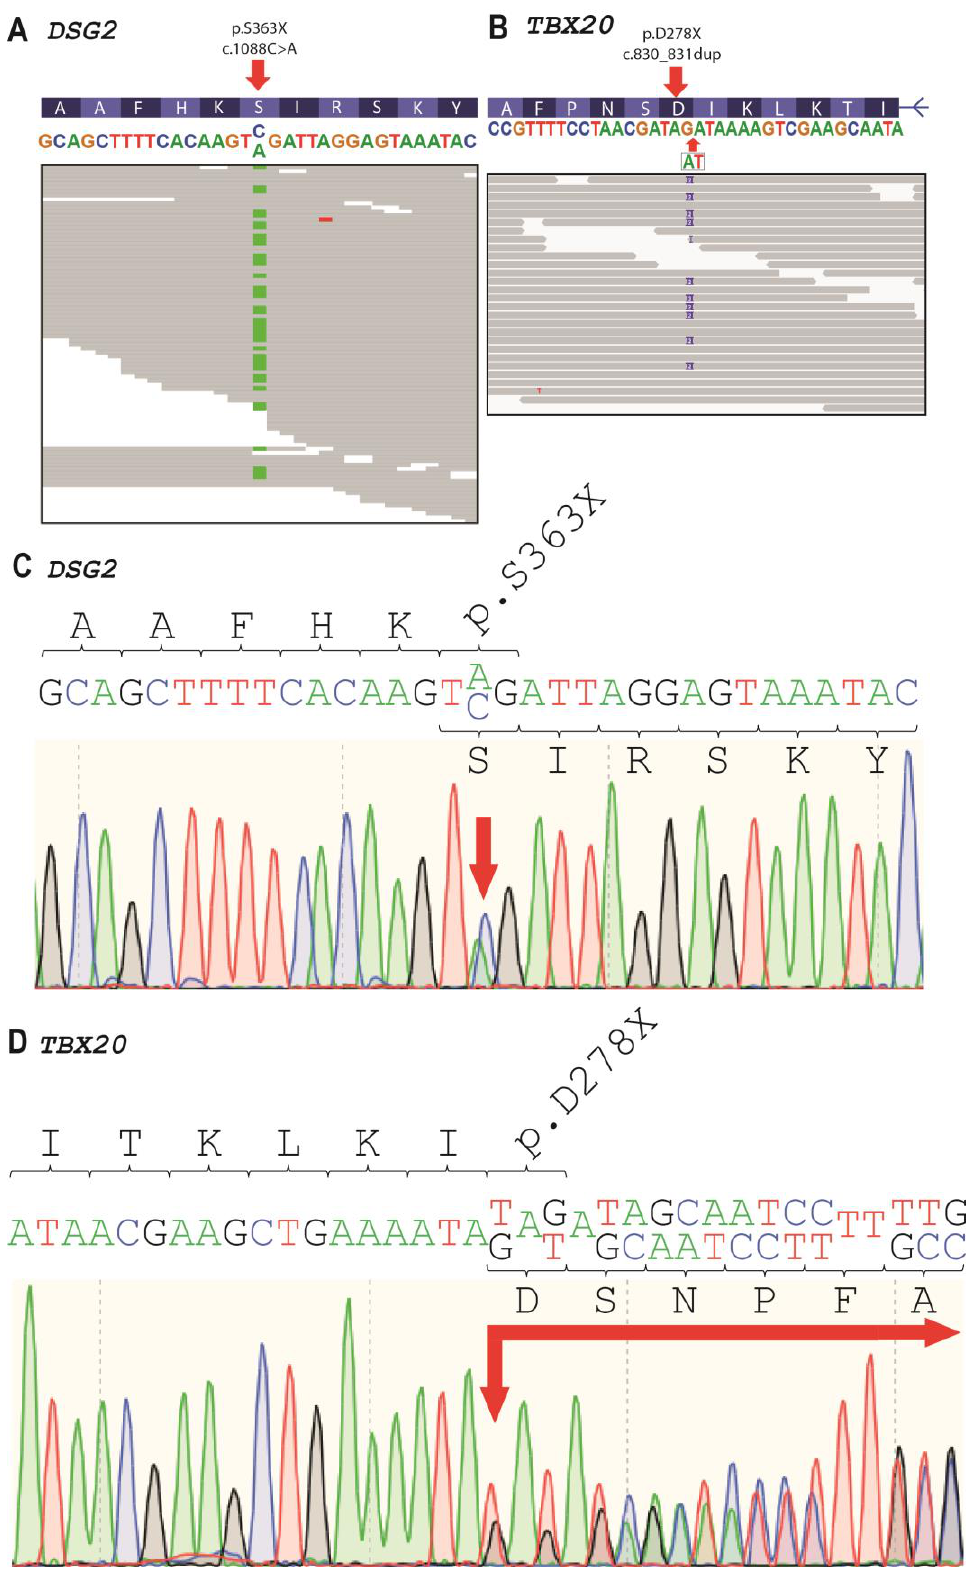
Figure 5. Genetic analysis of index patient (III-4). ( A , B ) Integrated genome view of DSG2 -p.S363X and TBX20 -p.D278X, respectively. ( C , D ) Electropherograms of DSG2 -p.S363X and TBX20 -p.D278X.